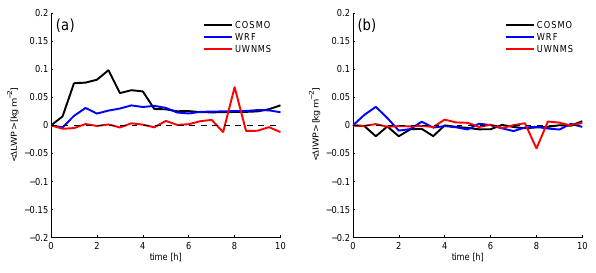
Fig. 8. Same as Fig. 6 but for the difference between the polluted case and the clean case in simulation SIM 1. The thin black dashed line indicates the zero